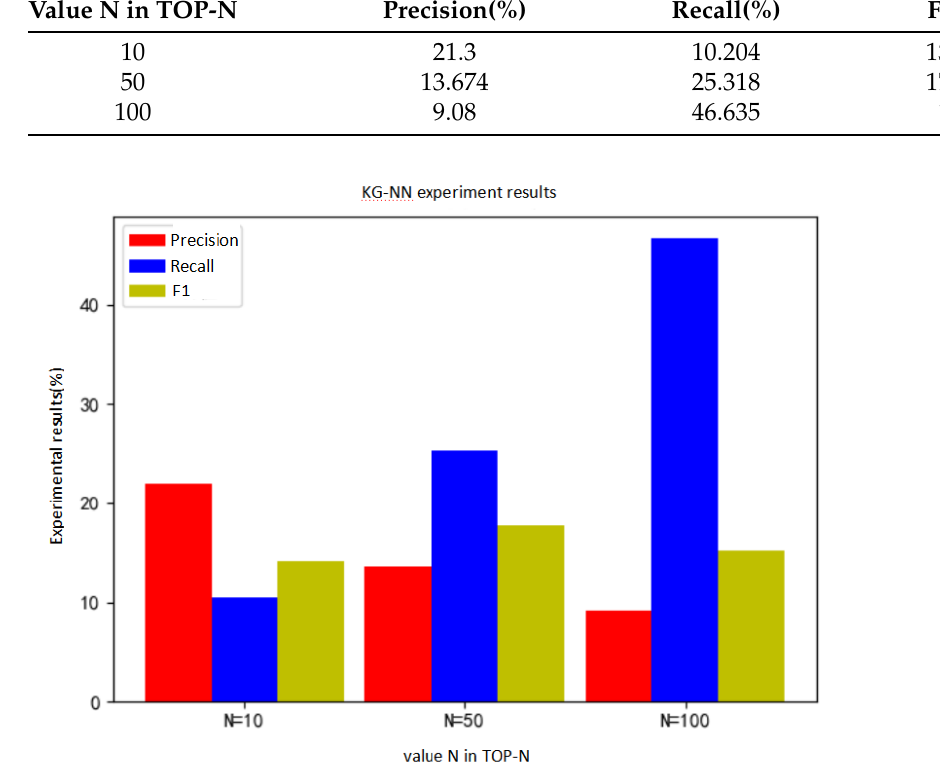
Figure 17. Experimental results under different N